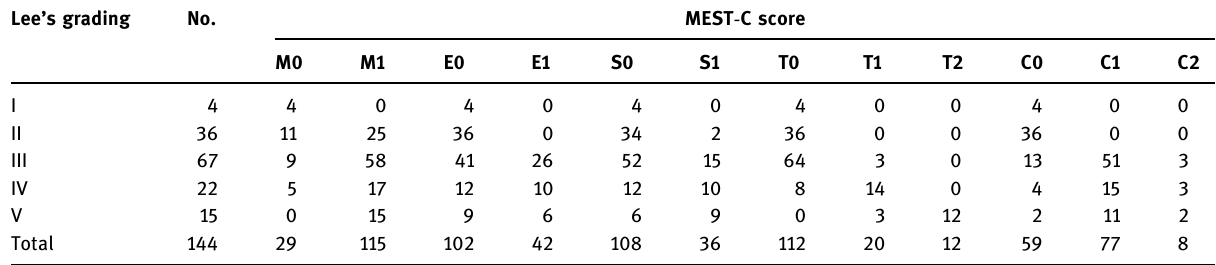
Table 1: Pathological classi fi cation of 144 patients with IgAN Lee ’ s grading No.